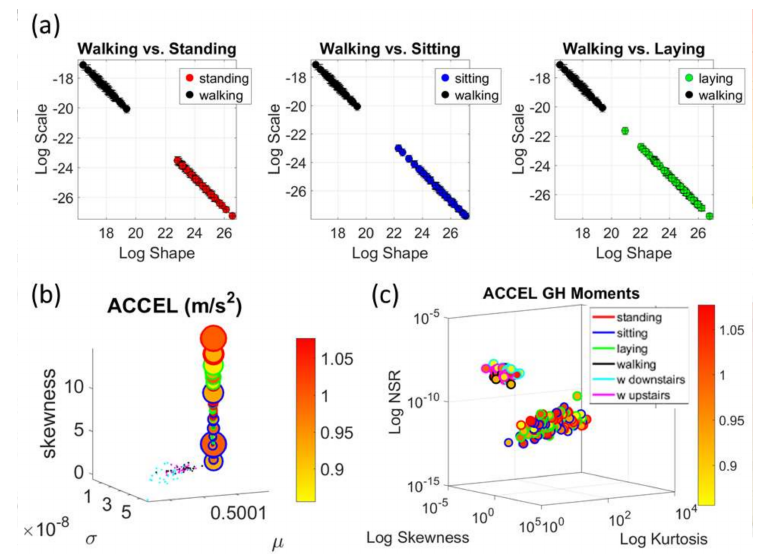
Figure 6. Comparison of tasks that require overt vs. covert movements. ( a ) Walking vs. standing, sitting or lying for all 30 participants plotted as points representing the distribution of spike trains of fluctuations in timing. ( b ) The corresponding Gamma moments estimated from the shape and scale parameters for each participant also separate and reveal differences in the skewness and kurtosis (marker edge color codes the task according to legend) in ( c ) where the z -axis represents the dispersion and separates the activities into two clearly self-emerging clusters of tasks with higher NSR (walking, walking upstairs and walking downstairs), whereas the skewness and kurtosis show a broader spread for tasks that require less overt motions (standing, sitting and